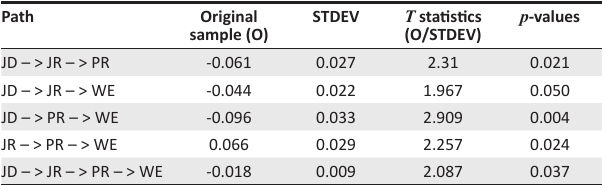
TABLE 6: Specific indirect